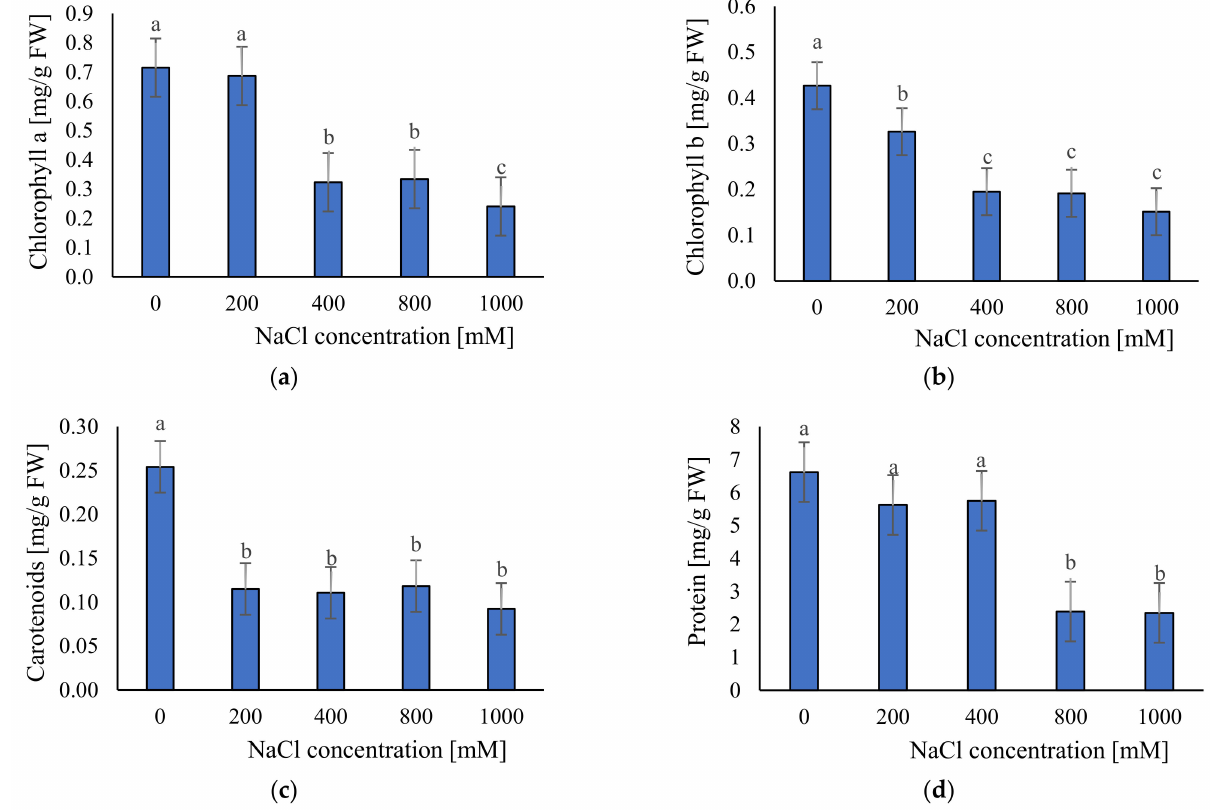
Figure 6. The average concentration of: ( a ) chlorophyll a; ( b ) chlorophyll b; ( c ) carotenoid; and ( d ) soluble protein in the tested plants; ± SD in the tested samples. ANOVA p < 0.001, significant differences based on post hoc Tukey’s test are marked with different